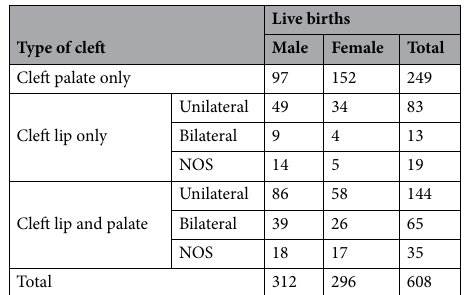
Infants with non- isolated clefts